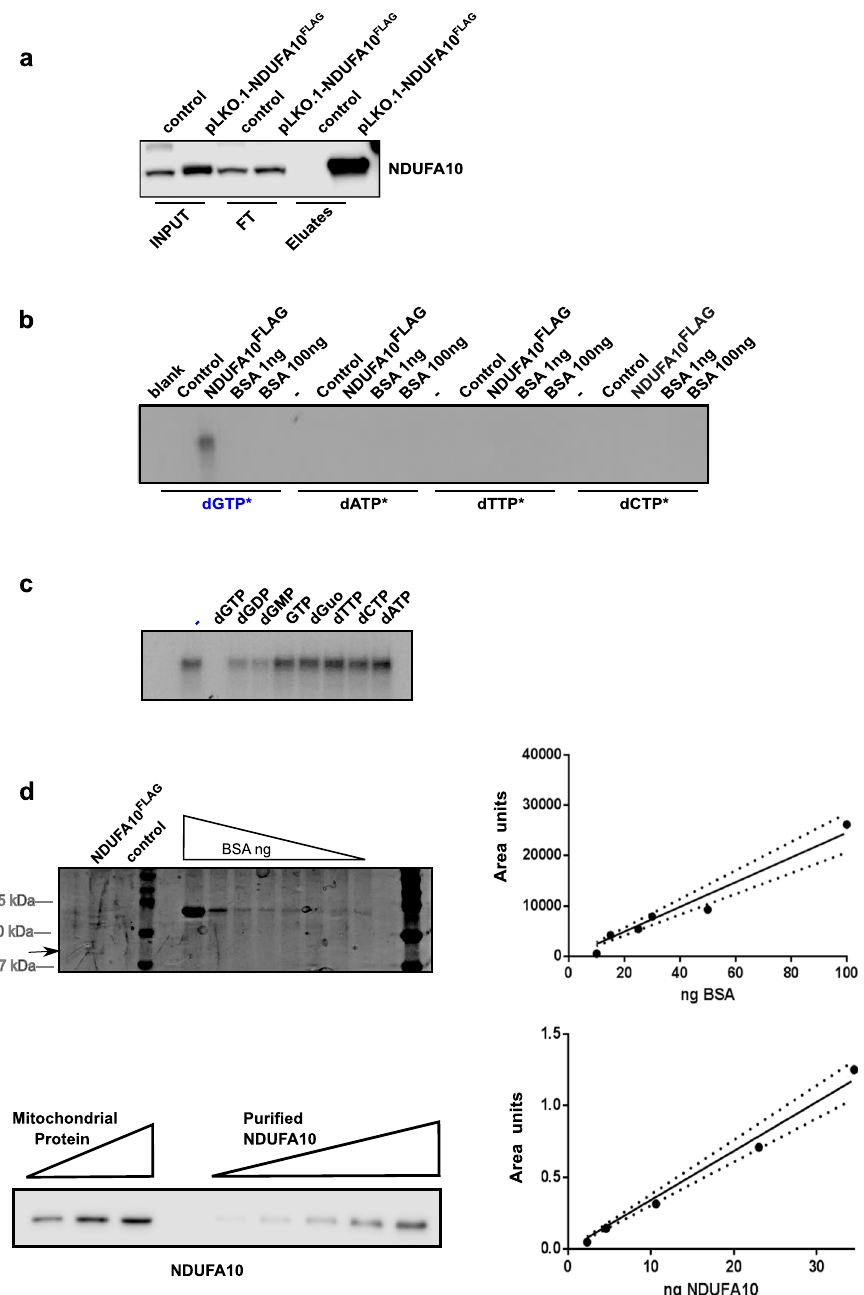
Fig. 5 NDUFA10 nucleotide binding capacity is speci fi c for dGTP. a Western blot analysis of NDUFA10 IP with anti-FLAG M2 antibody on NDUFA10 FLAG HeLa cell protein lysates. Lysates from HeLa cells transformed with pLKO.1-empty vector were used as a control. Image shows immunodetection with anti- NDUFA10 antibody on collected IP fractions (input, fl ow-through and eluates) were tested with anti-NDUFA10 antibody. b Autoradiography of a photoaf fi nity labeling assay with immunopuri fi ed NDUFA10 FLAG and [ α - 32 P]-dNTP. Eluates from HeLa cells transformed with empty pLKO.1 (control) and 1 ng or 100 ng of BSA were used to test for unspeci fi c binding c Autoradiography image of a photoaf fi nity labeling assay with immunopuri fi ed NDUFA10 FLAG , [ α - 32 P]-dGTP, and a 100-fold molar excess of cold dNTPs (dATP, dTTP, dGTP, and dCTP), different guanine-containing nucleotides (dGDP, dGMP, and GTP) and dGuo. d Relative quanti fi cation of NDUFA10 in mouse liver mitochondria. 15 µ L of immunopuri fi ed NDUFA10 FLAG (black arrow) were resolved next to a BSA standard curve (200, 100, 50, 30, 25, 20, 15, 10, and 0 ng) in a 12% SDS-PAGE. After Coomassie blue-G250 staining, the concentration of immunopuri fi ed NDUFA10 FLAG was inferred from the BSA standard regression curve (area units/ng BSA) y = 245.31x; R 2 = 0.9594 (right top graph). A growing curve of immunopuri fi ed NDUFA10 FLAG (2.3, 4.6, 10.6, 23, and 34.5 ng) was subsequently loaded next to a mouse mitochondrial liver lysate (10, 20, and 30 µ g of protein) in a 12% SDS-PAGE (left bottom panel). NDUFA10 was detected by subsequent western blotting using anti- NDUFA10 speci fi c antibody. The resulting regression curve (area units/ng NDUFA10 FLAG ) was used to determine the amount of NDUFA10 in liver mitochondrial lysate; y = 0.034x; R 2 = 0.9815 (right bottom graph). Dots represent mean values in the regression curve. The discontinuous lines depict the associated standard